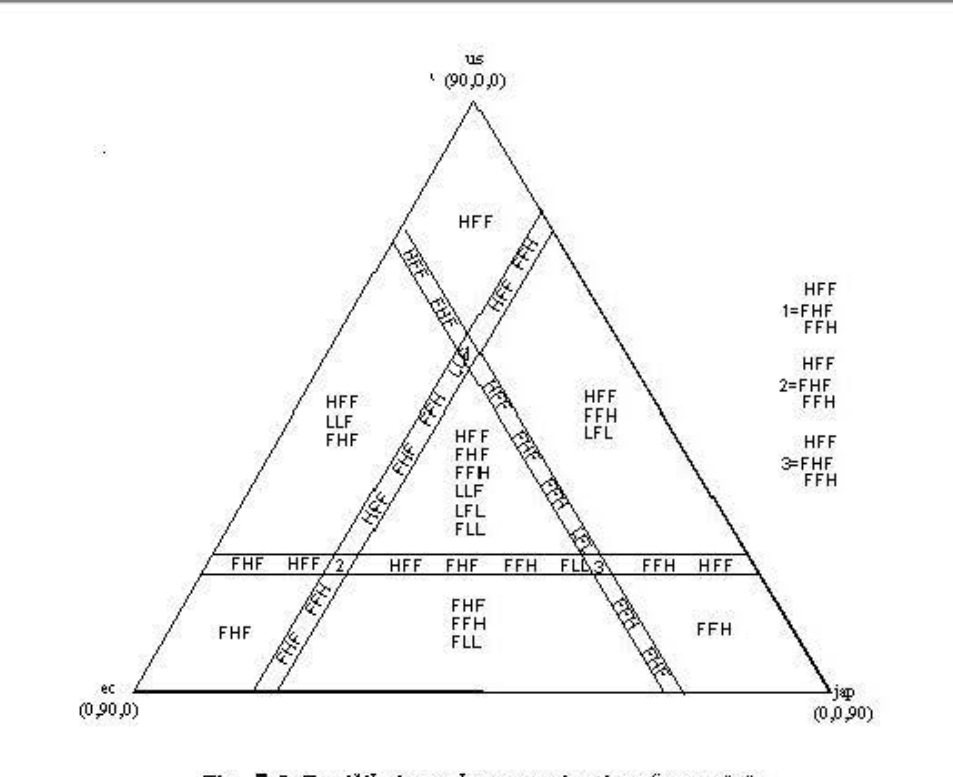
Fig. 7.5 Equil ibri11111 d1m,1''ferfZ(lff()r.fiJr c=